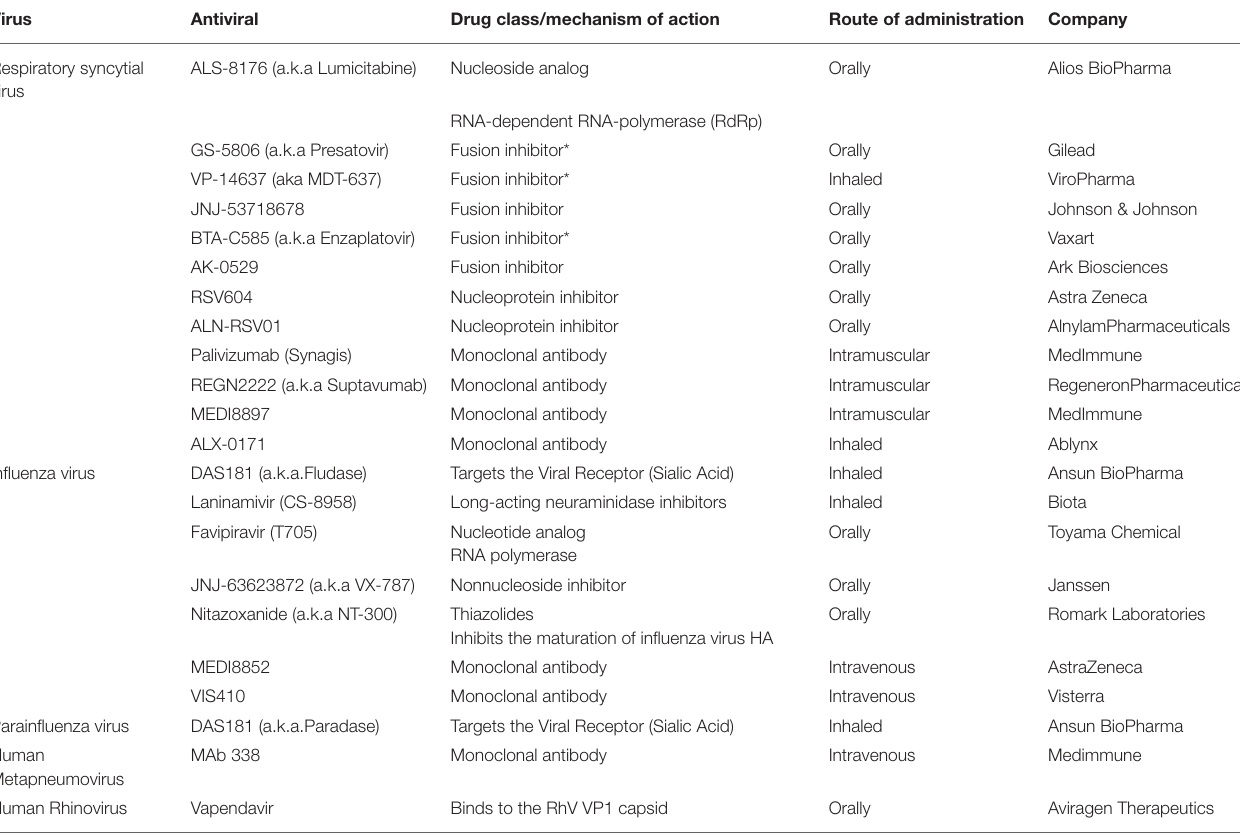
TABLE 4 | Antivirals and monoclonal antibodies on the pipeline for treatment of the major human respiratory RNA viruses.